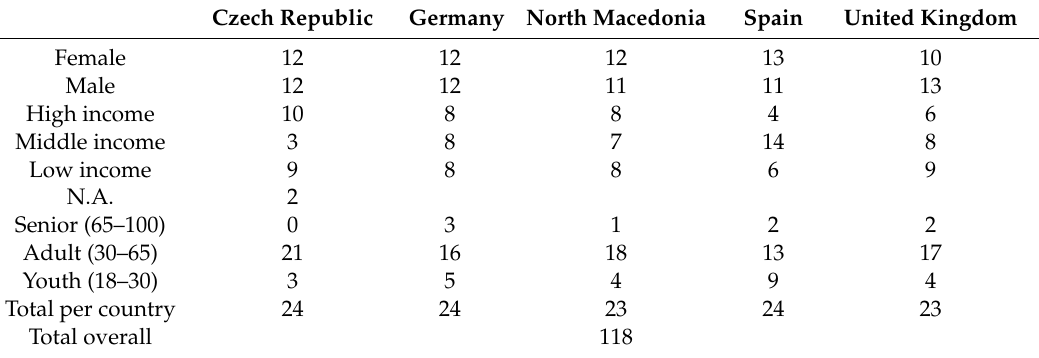
Table 1. Summary of participant’s key socio-demographic